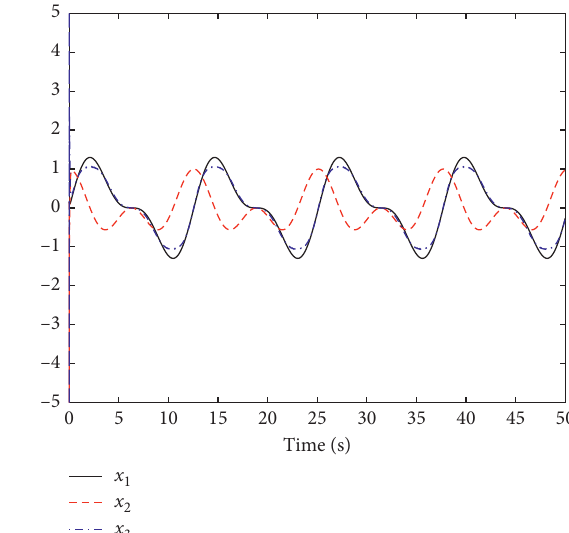
Figure 7: System output y and reference signal y